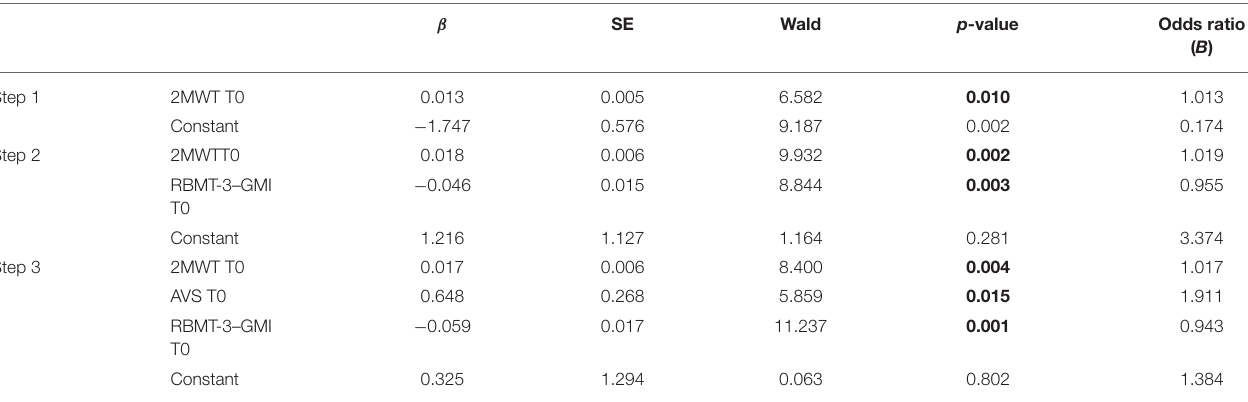
TABLE 7 | Binary logistic regression model to test best predictors of the RBMT-3–GMI change after